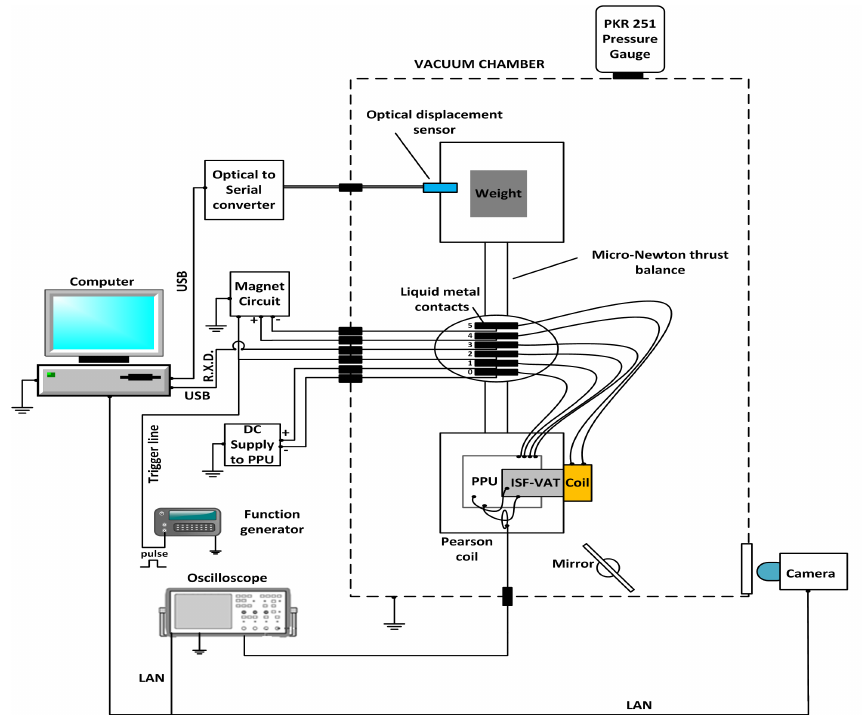
Figure 5. Schematic of the experimental setup and diagnostics system.